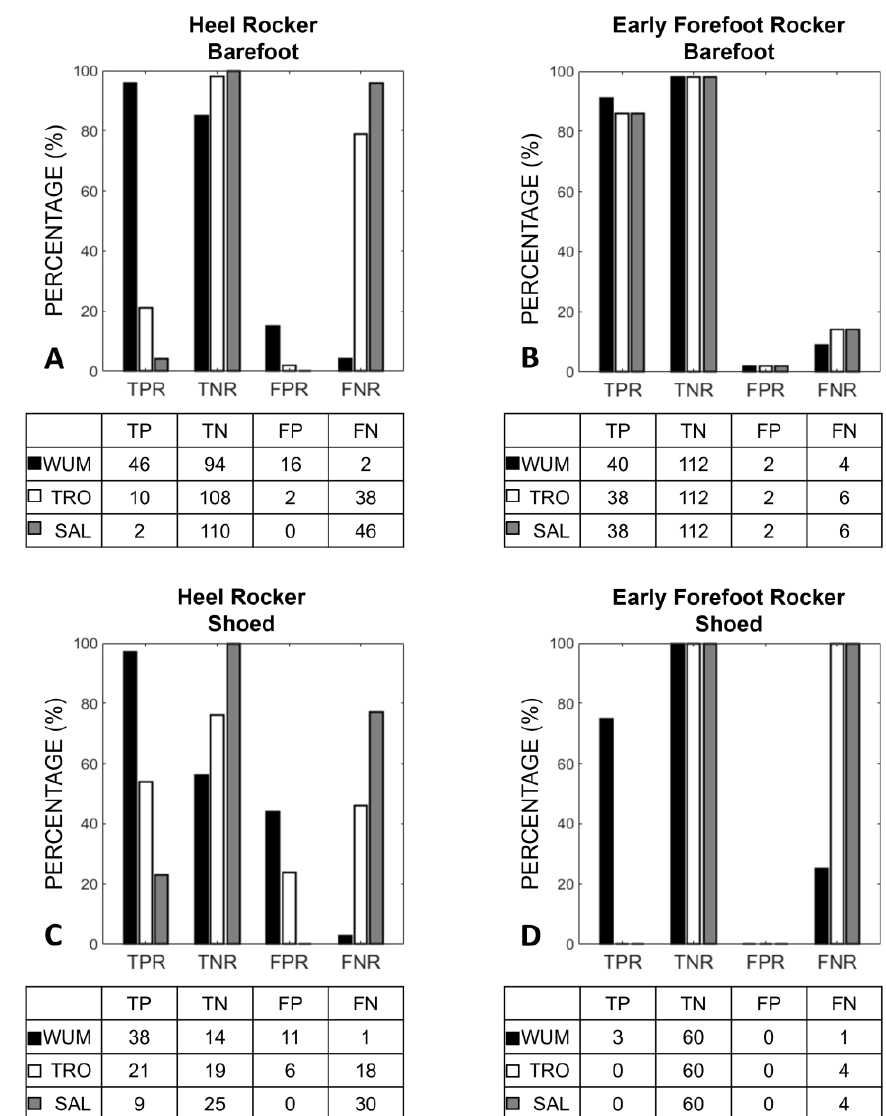
Figure 6. Characterization of heel rocker during barefoot ( A ) and shoed ( C ) walking and early forefoot rocker during barefoot ( B ) and shoed ( D ) walking, based on the FSs identified with the three algorithms. In the graphs, black, white, and grey bars represent WUM, TRO, and SAL, respectively. In the shoed condition, for both heel and forefoot rockers characterization, the highest TPR (97%) and TNR (100%) were achieved using WUM and SAL, respectively, while the lowest FPR (0%) and FNR (3%) were achieved using SAL and WUM,